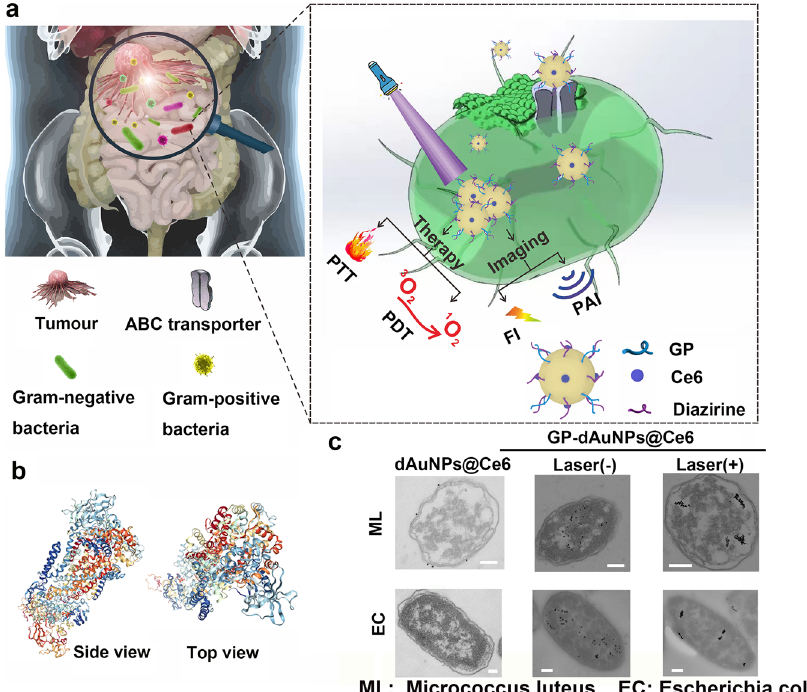
Fig. 1 Schematic design and characterization of bacteria eating gold nanoparticles for aggregation-enhanced imaging and killing bacteria. a Schematic showing bacteria eating gold nanoparticles for aggregation-enhanced imaging and killing bacteria. The imaging models include fl uorescence imaging (FI) and photoacoustic imaging (PAI). The therapeutic methods include photothermal therapy (PTT) and photodynamic therapy (PDT). b Structure of ABC transporter in E. coli (Left: side view; Right: top view). The sequences of ABC transporter in E. coli were obtained from http://www.rcsb.org/ and the structure was simulated by PyMOL software. c TEM images of M. luteus (ML) or E. coli (EC) treated by 1.0 mg mL − 1 of diazirine and chlorin e6 (Ce6)- modi fi ed gold nanoparticles (AuNPs) (dAuNPs@Ce6) or GP (e.g., poly[4-O-( α -D-glucopyranosyl)-D-glucopyranose]), diazirine and Ce6-modi fi ed gold nanoparticles (AuNPs) (GP-dAuNPs@Ce6) at 37 °C for 2 h. After incubation, the treated bacteria were rinsed with PBS buffer for several times. GP- dAuNPs@Ce6-treated bacteria were subjected with or without laser irradiation (405 nm, 1.0 W cm − 2 , 25 min). The bacterial cell concentration is ~1.0 × 10 7 CFU. Scale bars, 200 nm. All imaging experiments were repeated three times with similar results. The cartoons are created by Dr. Houyu